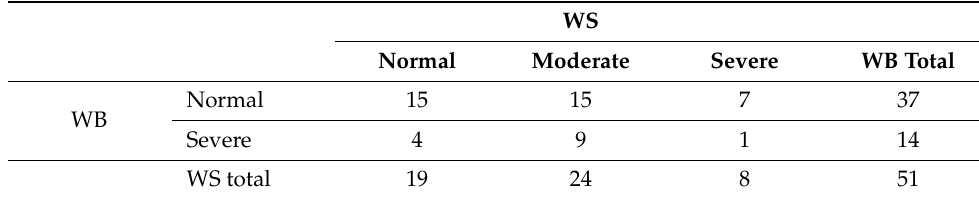
Table 2. Bird count for the various myopathy scores.